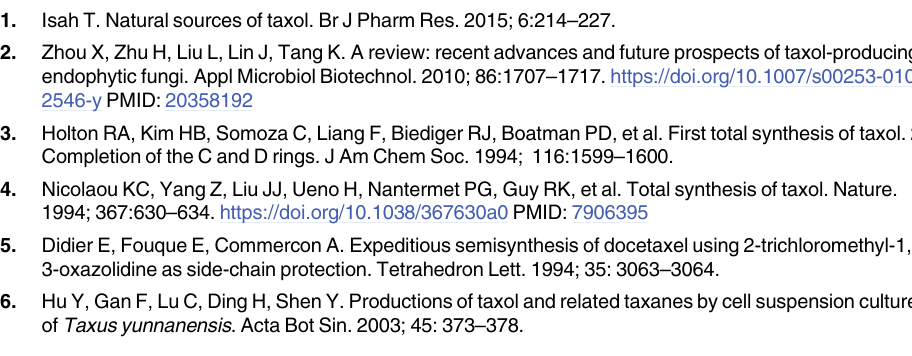
S1 Table. Total lipid profile of P . microspora from without SA amended mycelia and posi- tive control by GC-MS analysis. S2 Table. Total lipid profile of P . microspora from 300 μ M of SA amended mycelia by GC-MS